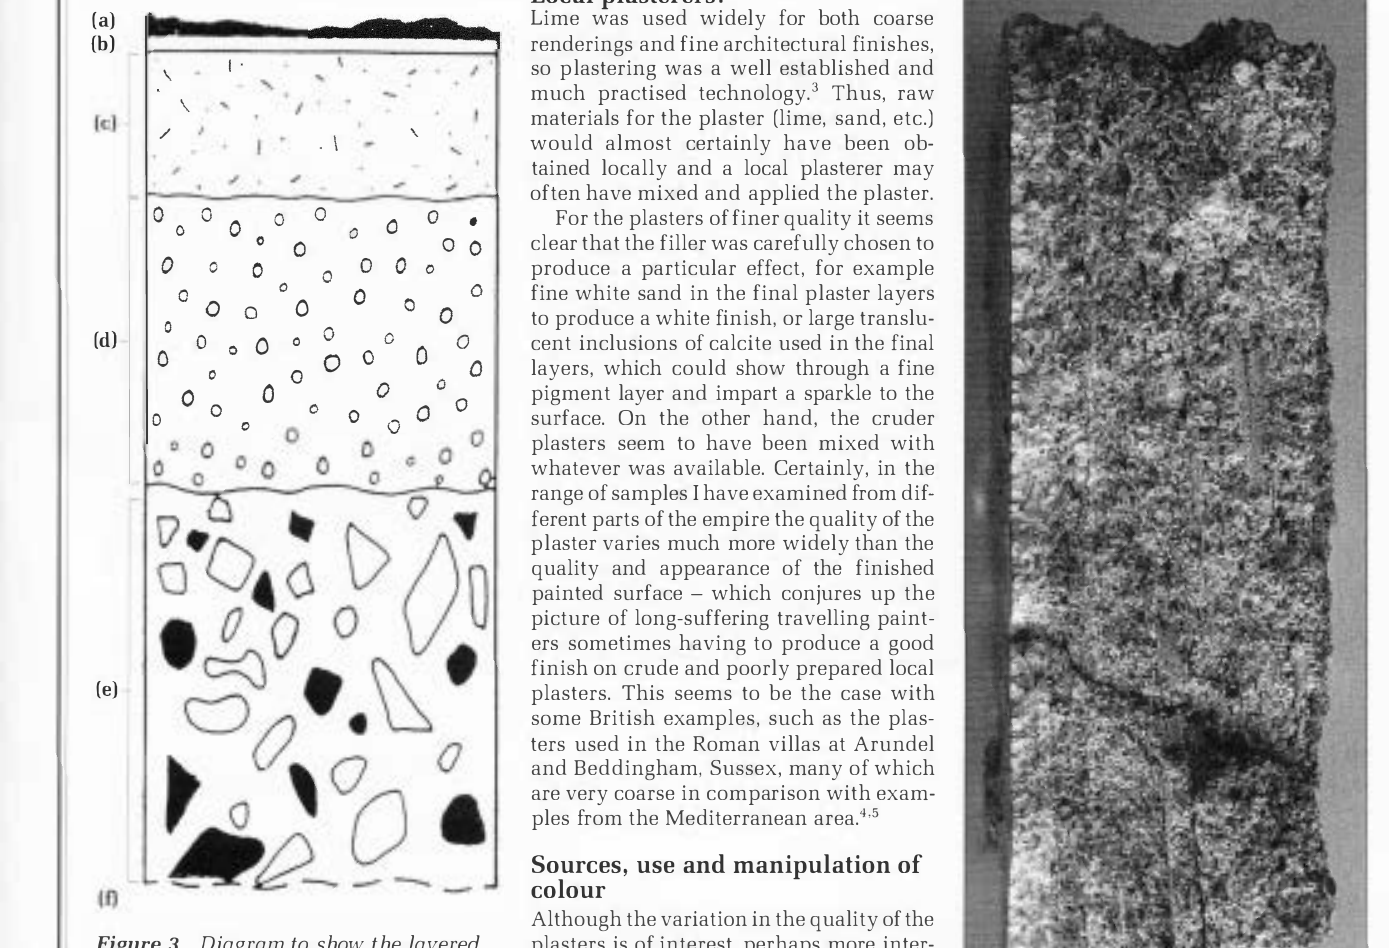
Figure 3 Diagram to show the layered structure of painted wall plaster. (a) The painted surface; {b) layer of pure lime usu­ ally 1-2 mm thick, not always present; (c) fine plaster, often less than 1 cm thick and sometimes mixed with ground marble or other white filler; (d) coarse plaster, often more than 1 cm thick; (e) preparation layer of plaster of varying thickness, mixed with coarse filler and applied direct to the wall; {f) wall below the plaster layers. of rectangular or square fields of colour outlined by bands of another colour; the fields might be plain or might contain figurative, architectural